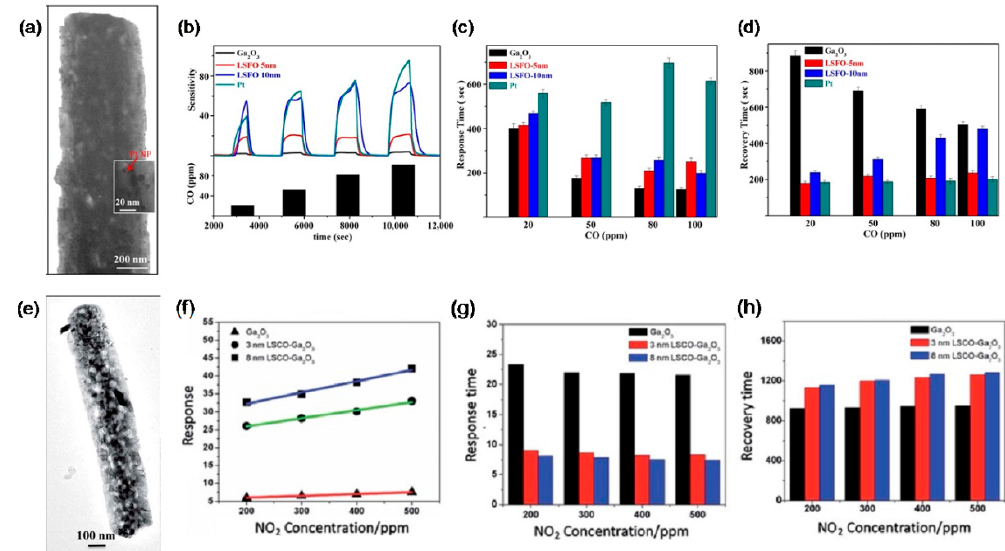
Figure 15. ( a ) TEM image of a β‐ Ga 2 O 3 nanorod coated with 5 nm LSFO. ( b ) Sensitivity, ( c ) response time, and ( d ) recover time of gas sensors made by β‐ Ga 2 O 3 /LSFO nanorods upon exposure to CO at 500 °C [154]. Copyright 2016 American Chemical Society. ( e ) TEM image of a β‐ Ga 2 O 3 nanorod coated with 8 nm LSCO. ( f ) Sensitivity, ( g ) response time, and ( h ) recover time of gas sensors made by β‐ Ga 2 O 3 /LSCO nanorods upon exposure to NO 2 at 800 °C [161]. Copyright 2020 The Royal Society of Chemistry.